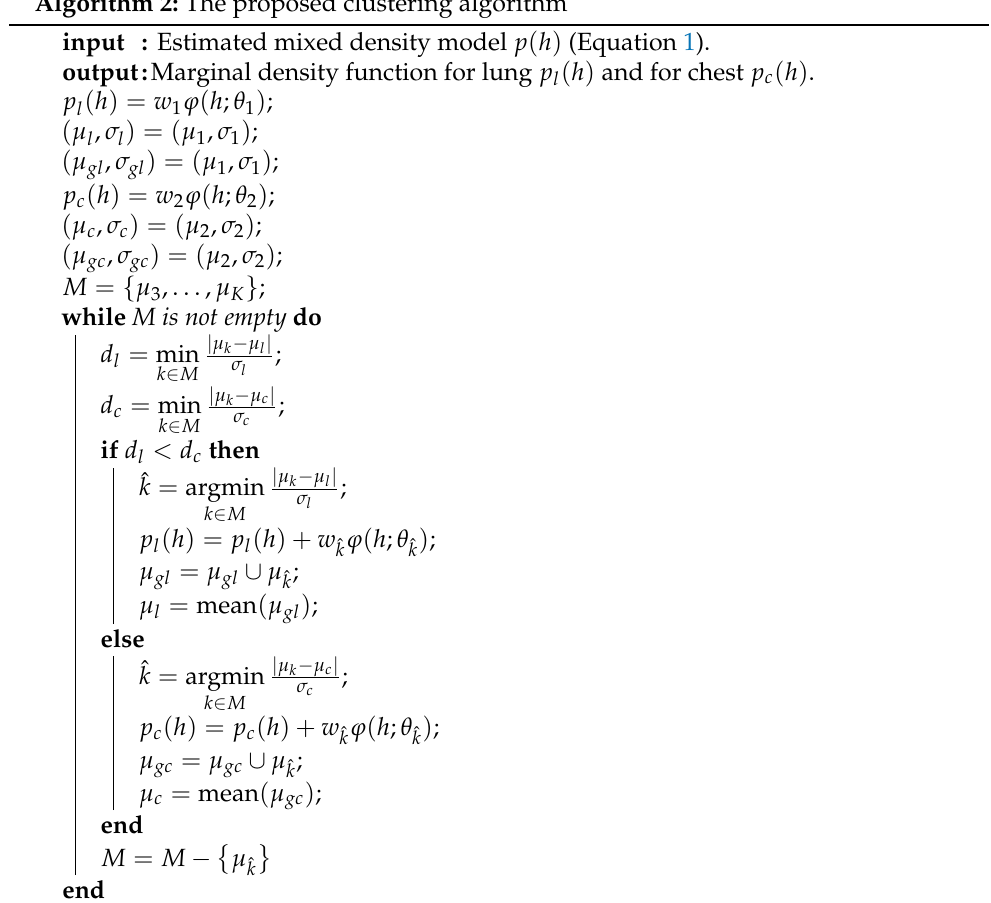
Algorithm 2: The proposed clustering